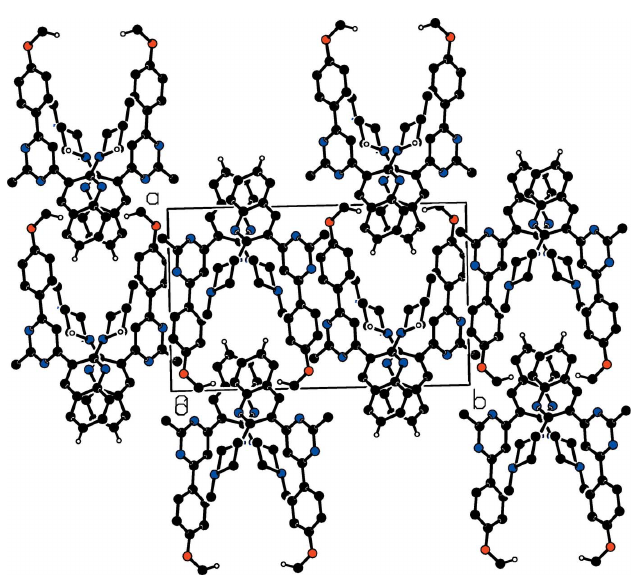
Figure 2 Part of the crystal structure. Only H atoms involved in the C—H (cid:3)(cid:3)(cid:3) (cid:2) interactions are shown.